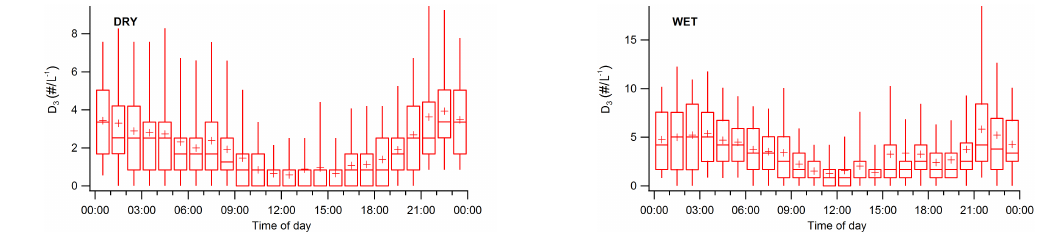
Figure 6. As Fig. 3 but showing cluster D 3 during dry periods (top), and wet periods (bottom).